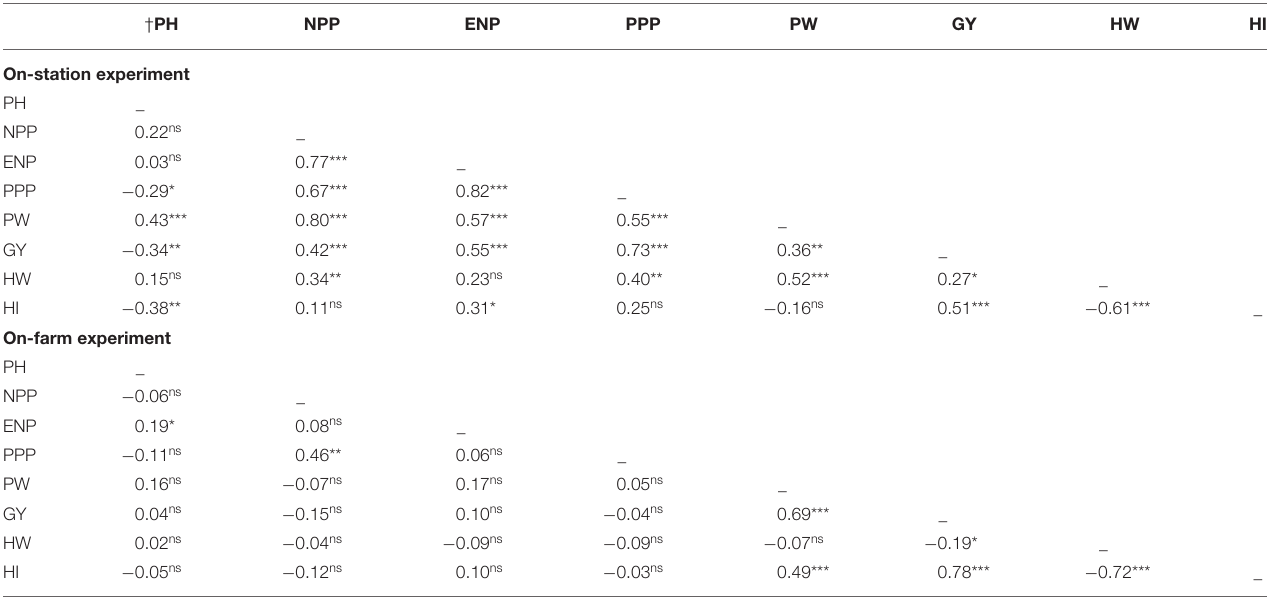
TABLE 5 | Coefficient of correlation ( r ) among plant height, nodulation, yield, and yield components of groundnut in the on-station and on-farm experiments. †